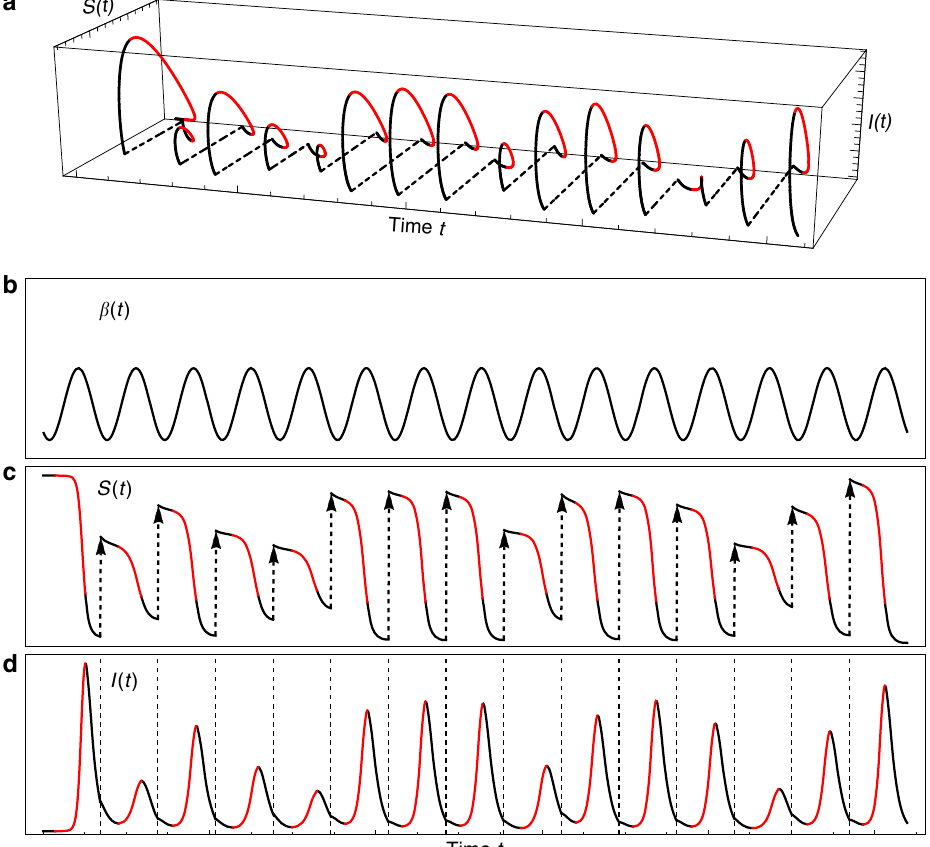
Fig. 1 Schematic illustration of SIR dynamics with randomly reset susceptible populations. a Schematic illustration showing an attractor expanded out in time with unstable outbreak periods (red) and stable inter-outbreak periods (black) that are stochastically reset (dashed lines). The attractor was constructed from a realization of an SIR model with a periodically varying β ( t ) to represent the seasonal cycle, as shown in ( b ), but where each year the population ’ s susceptible pool is drawn randomly (the stochastic reset). c The annually reset dynamics of S ( t ) is shown in ( c ). d The dynamics of I ( t ). The fi gure is constructed using β ( t ) = a + b (1 − cos(2 π t / τ − ϕ )), and parameters τ = 1 year, a = 0.0005, and b = 0.001. At times t = k τ , k = 1, … , 14, the initial conditions were reset to S = r , where r is a random variable with the uniform distribution over {60, 70, … ,